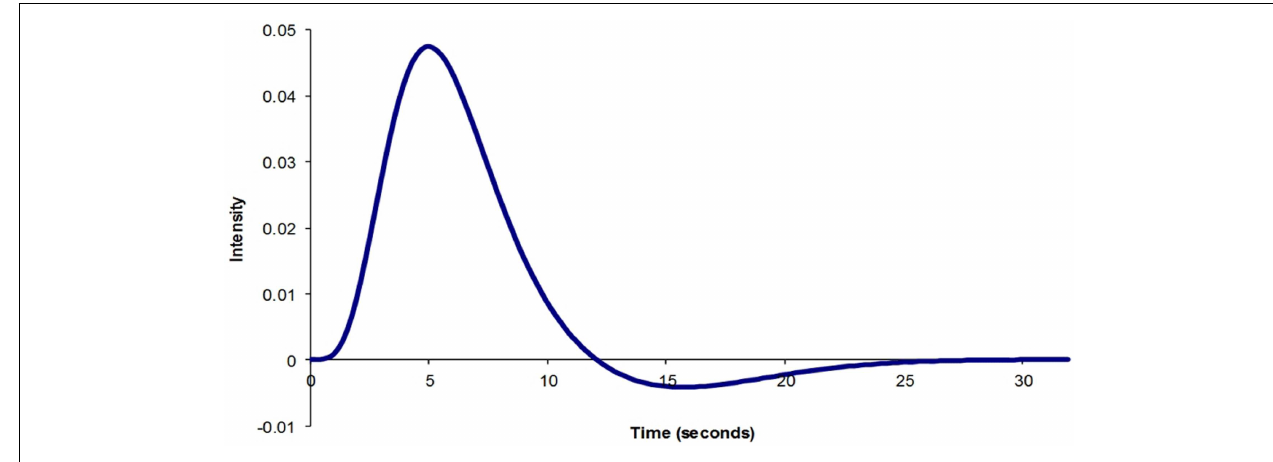
FIGURE 1 |Typical BOLD impulse response model generated using SPM8